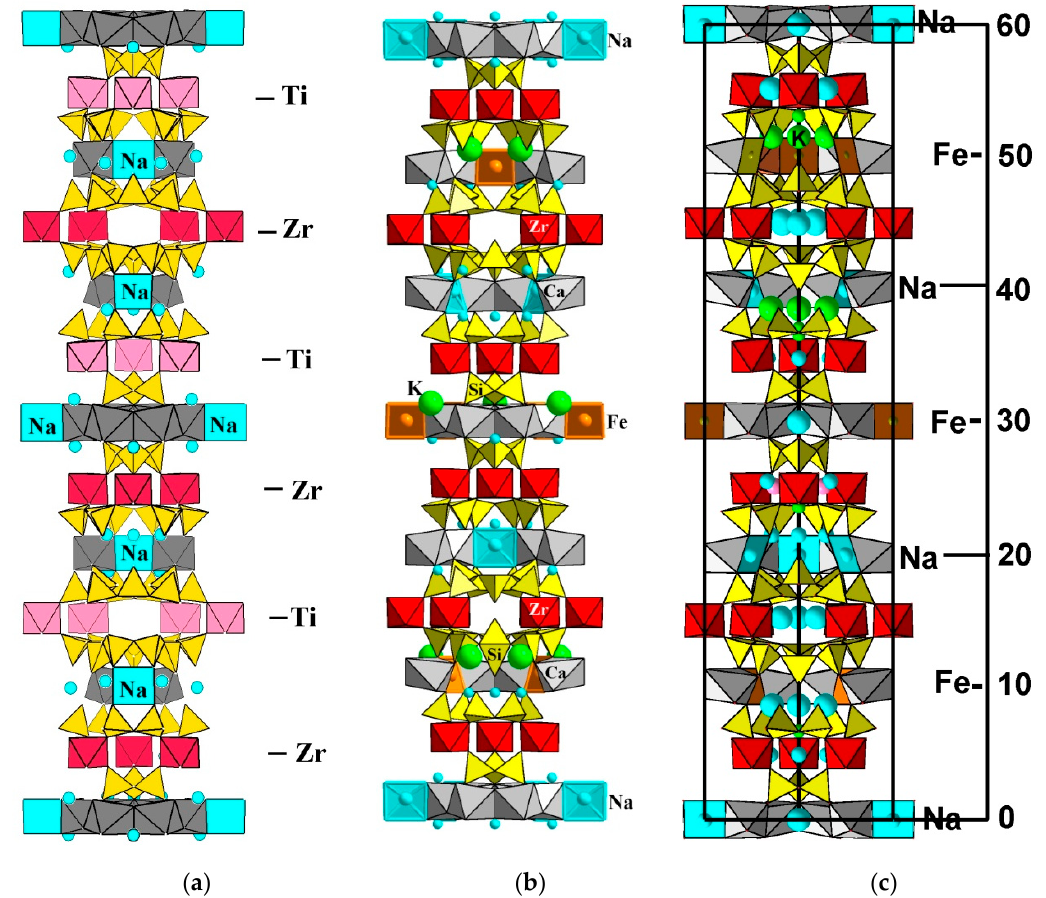
Figure 14. Ordered isomorphism at the Z site in dualite [73] ( a ), at the M 2 and N 3 sites in rastsvetaevite holotype [23,74] ( b ), and at the M 2 and N 4 sites in hydrated rastsvetaevite [8,75] ( c ), viewed along (210).